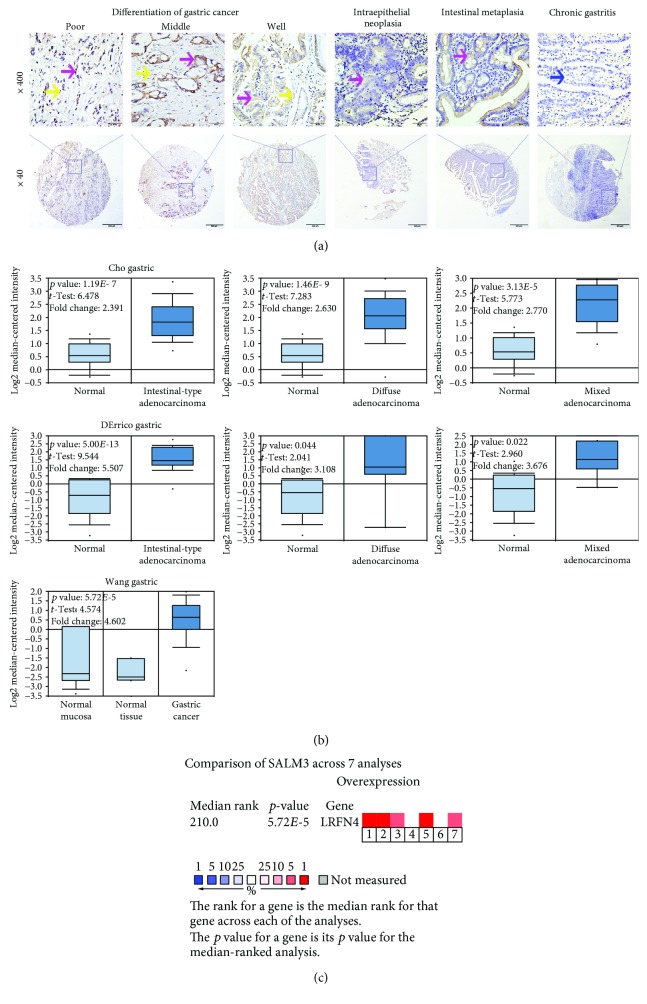
High expression of SALM3 in gastric cancer cells and fibroblasts. (a) Representative images of SALM3 expression in benign and malignant gastric tissue samples: positive tumor cytoplasm (purple arrow), fibroblasts (yellow arrow), and negative staining (blue arrow) of immunohistochemical staining of SALM3. Rows 1 and 2 are SALM3 staining at a magnification of 400x (bar = 50 μm) and 40x (bar = 500 μm), respectively. (b) Box plots from gene expression data in Oncomine comparing the expression of SALM3 in normal and GC tissues. The p value was set up at 0.01, and fold change was defined as 2. (c) A meta-analysis of SALM3 gene expression from 3 Oncomine databases, where colored squares indicate the median rank for SALM3 (vs. normal tissue) across 7 analyses: Cho's gastric (1-3), DErrico's gastric (4-6), and Wang's gastric (7). The p value is given for the median-rank analysis.